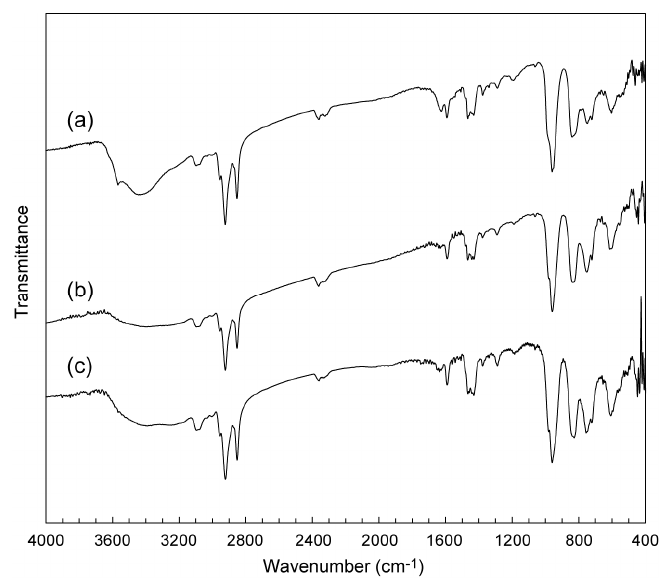
Figure 2. IR spectra of C 12 pda-V 10 hybrids: ( a ) dark green C 12 pda-V 10 hybrids synthesized at pH 6.0; ( b ) yellow C 12 pda-V 10 hybrids synthesized at pH 4.0; ( c ) C 12 pda-V 10 crystals obtained from the filtrate of the synthesis at pH 6.0.